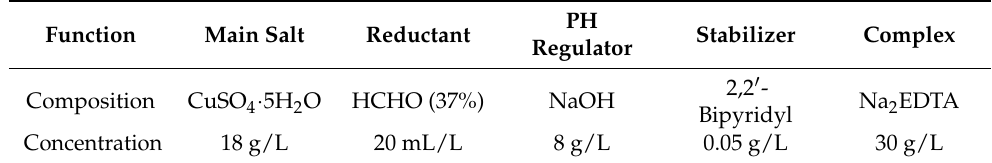
Table 1. The composition and concentration of bath solution. PH Function Main Salt Reductant PH Regulator Stabilizer Complex Function Main Salt Reductant Stabilizer Complex Regulator Composition CuSO 4 ·5H 2 O HCHO (37%) NaOH 2,2 ′ -Bipyridyl Na 2 EDTA 2,2 (cid:48) - Concentration 18g/L 20mL/L 8g/L 0.05g/L 30g/L Composition CuSO 4 · 5H 2 O HCHO (37%) NaOH Na 2 EDTA Bipyridyl Concentration 18 g/L 30 The required concentration solution of CuSO 4 ·5H 2 O (Shanghai Aladdin Biochemical